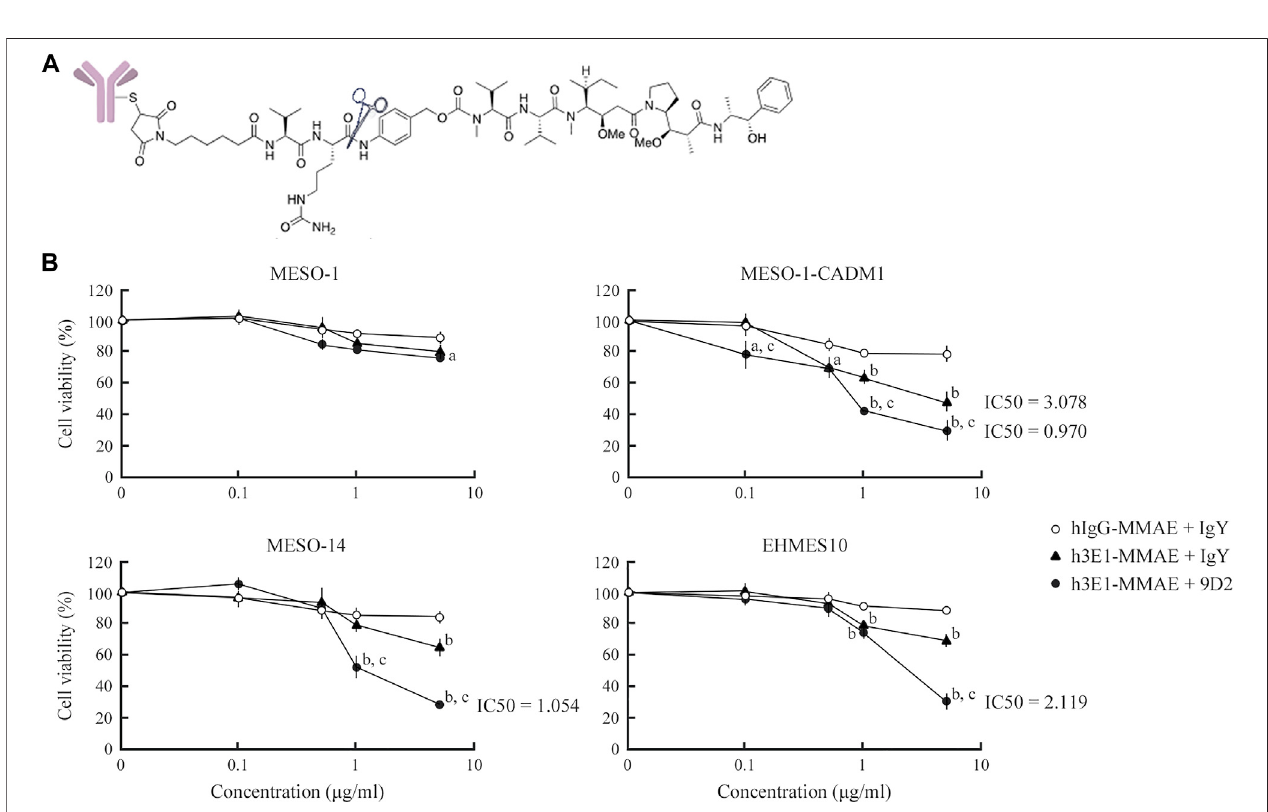
FIGURE 4 | Killing of MPM cells by h3E1 – MMAE ADC (A) Structure of h3E1 – MMAE ADC. The cathepsin cleavage site is indicated by scissors (B) MPM cells were culturedina96-wellplate at30%con fl uence,andeitherhIgG – MMAEorh3E1 – MMAEADCwasaddedalongwithwithercontrolIgYor9D2atindicatedconcentrations. After5 days,cellviabilitywascalculatedbyWST-8assaysintriplicate.Themeanisplottedinalinegraph,withathinverticallineindicatingthestandarddeviation. a and b , p -value < 0.05 and 0.01, respectively, when compared with the value of hIgG – MMAE ADC + IgY at the identical concentration. c , p -value < 0.01, when compared with the value of h3E1 – MMAE ADC + IgY at the identical concentration.